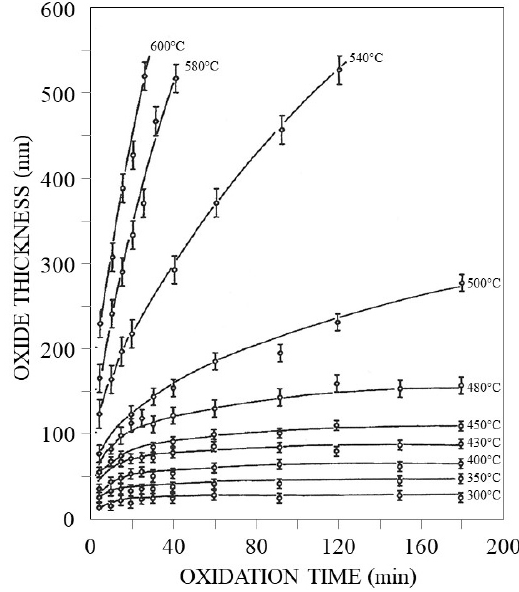
Figure 10. Oxidation kinetics (variation of the oxide film thickness with exposure time) in the air of a maraging 300 steel at various temperatures 48 .